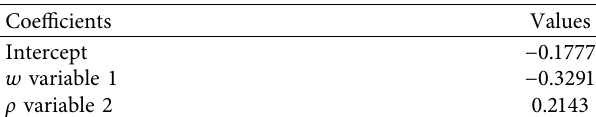
( t ) − log t of samples with different u ′